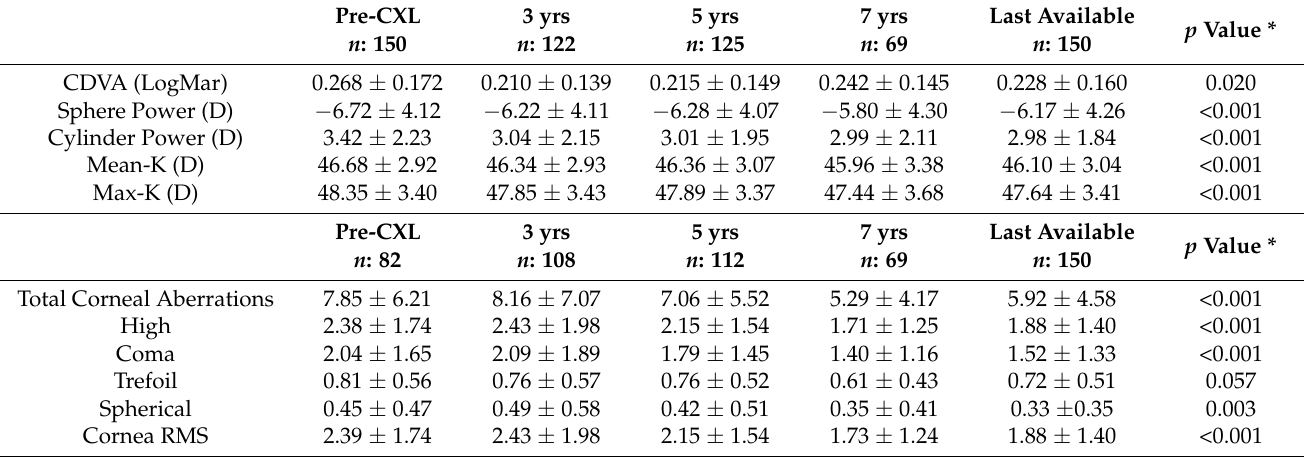
Table 1. Study measures over time. Values are presented as mean ± standard